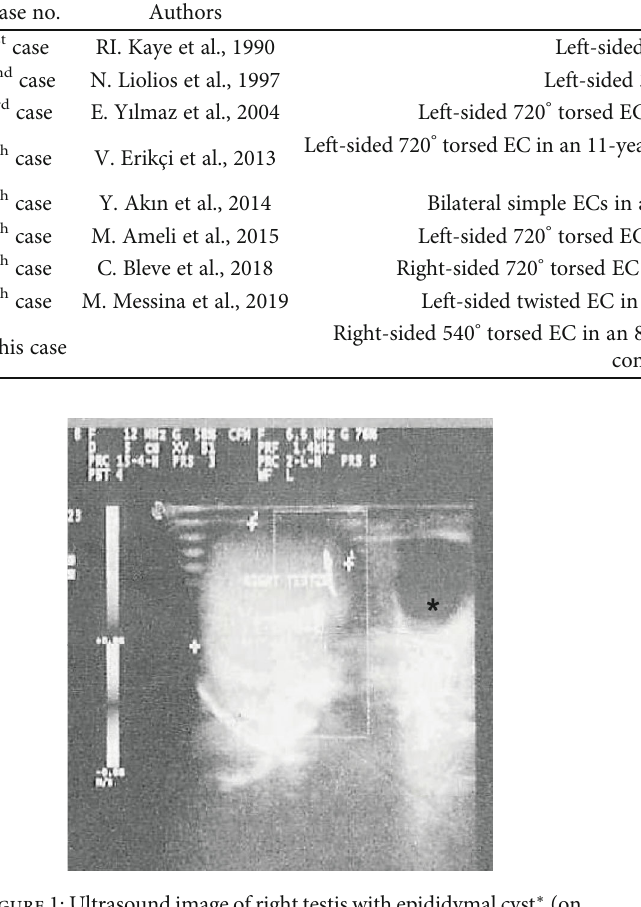
Figure 3: Untwisted hemorrhagic right Epididymal